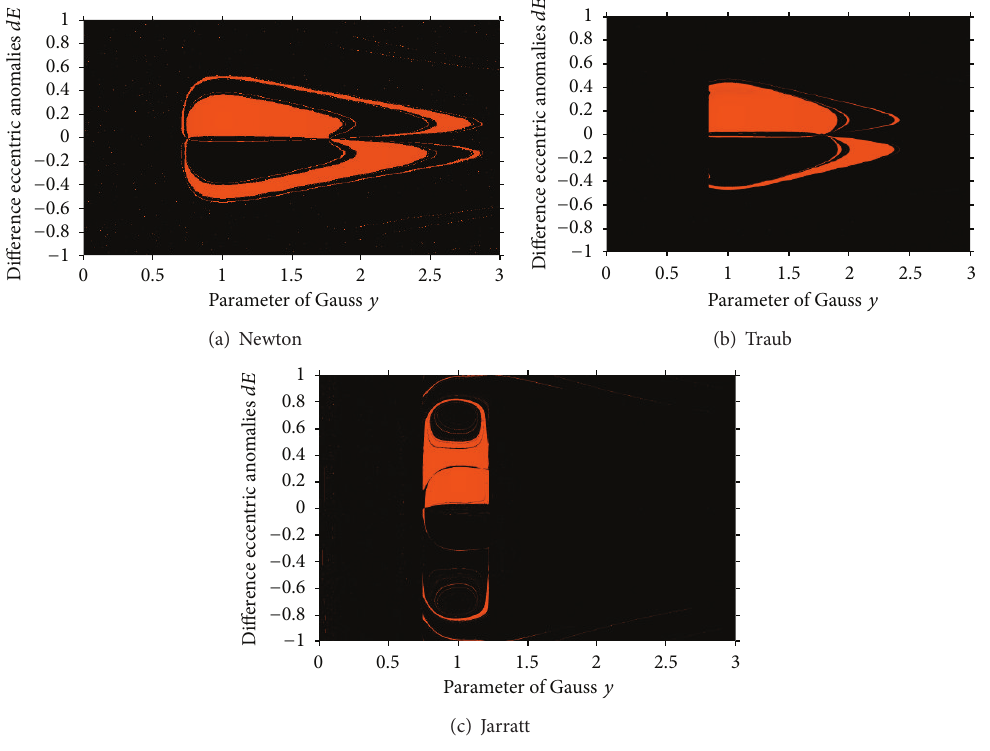
Figure 2: Dynamical planes from classical methods and Reference Orbit I.